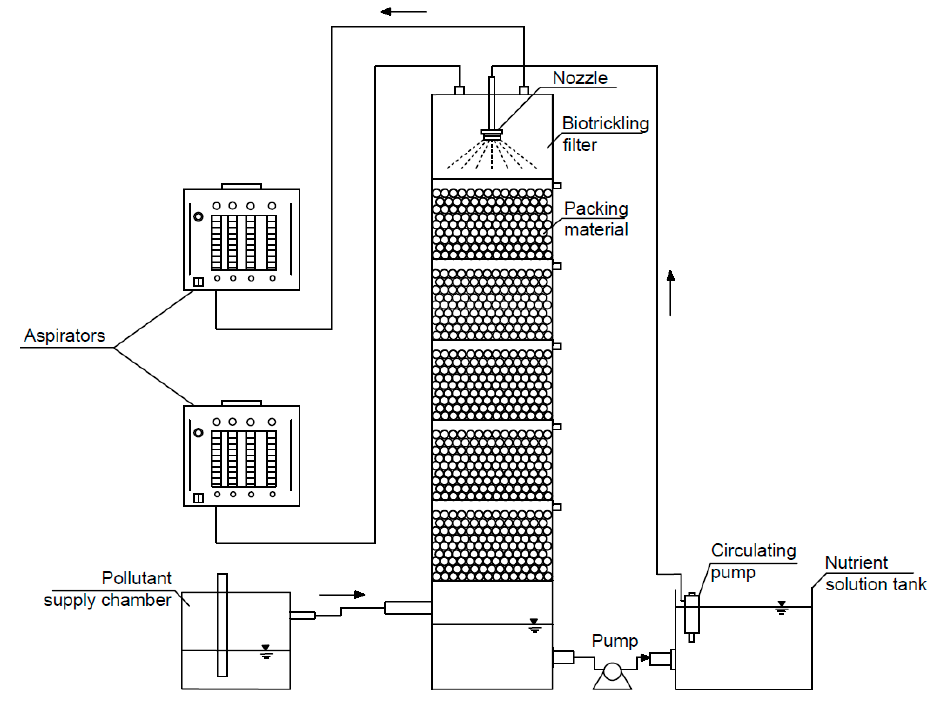
Figure 1. Schematic diagram of the biotrickling filter.